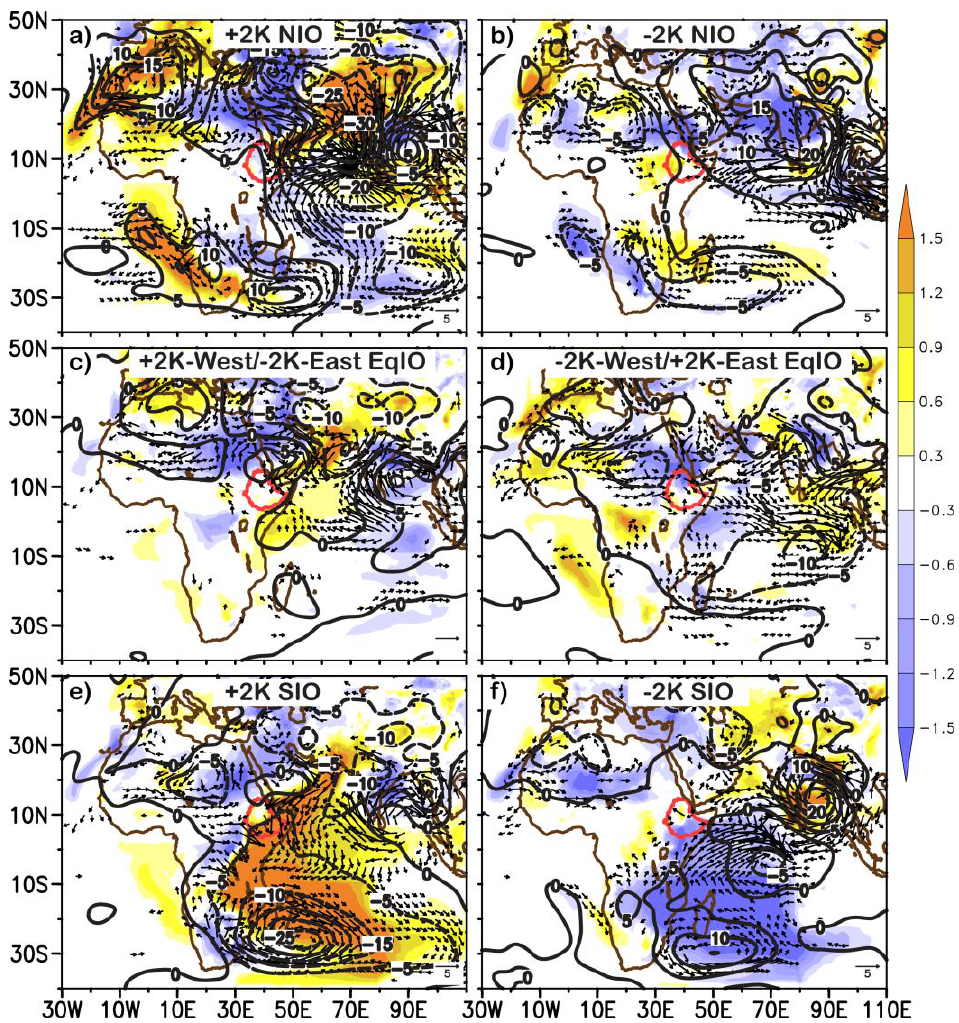
Figure 7. Circulation changes from CNTL at 850 hPa averaged for July-August corresponding to SST anomaly (SSTA) forcing over the ( a , b ) Northern Indian Ocean (NIO; 0°–25°N, 40°–75°E); ( c , d ) Equatorial Indian Ocean (EqIO; 10°S–10°N, 70°–100°E); and ( e , f ) Southern Indian Ocean (SIO; 10°–40°S, 30°–80°E). Each panel shows differences in horizontal winds (vectors; m·s −1 , magnitude scale in lower right corner), temperature (shading; K, color scale at right), and geopotential height (contours; gpm) between the perturbed SSTA forcing experiments and CNTRL. Differences of geopotential heights are contoured every 5 gpm. Anomaly vectors are plotted for resultant magnitudes of at least 1 m·s −1 only. The border of Ethiopia is delineated in solid red line. See Table 1 for description of